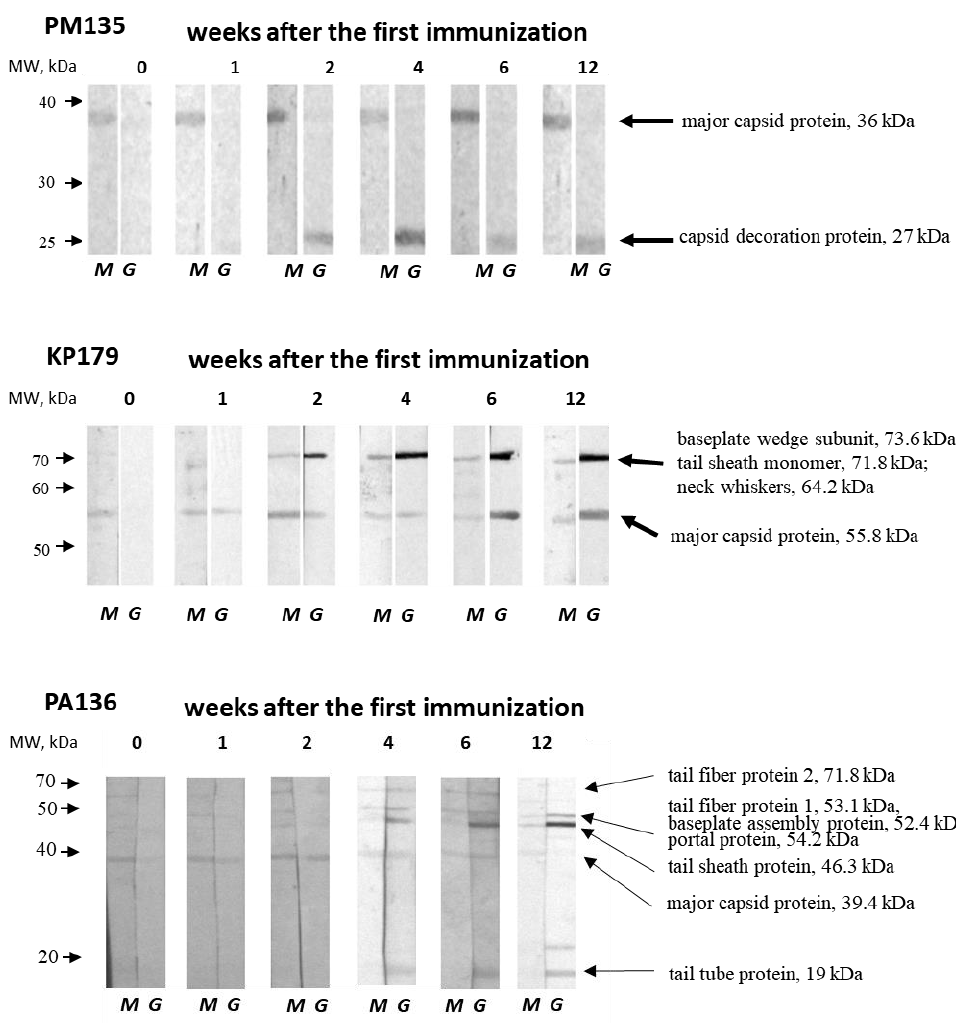
Figure 5. Western blot analysis of phage lysates fractioned using 12% SDS-PAGE and transferred onto a nitrocellulose membrane (Bio-Rad, USA). Phage proteins were revealed by anti-phage IgM (M) and IgG (G) antibodies from pooled serum samples obtained before immunization and 1, 2, 4, 6, and 12 weeks after the first immunization of mice injected three times with a selected phage (PM135, KP179, or PA136) without any adjuvants. The left arrows correspond to molecular weights of protein standards (Thermo Fisher Scientific, USA). The names and molecular weights of the identified proteins are indicated on the right.